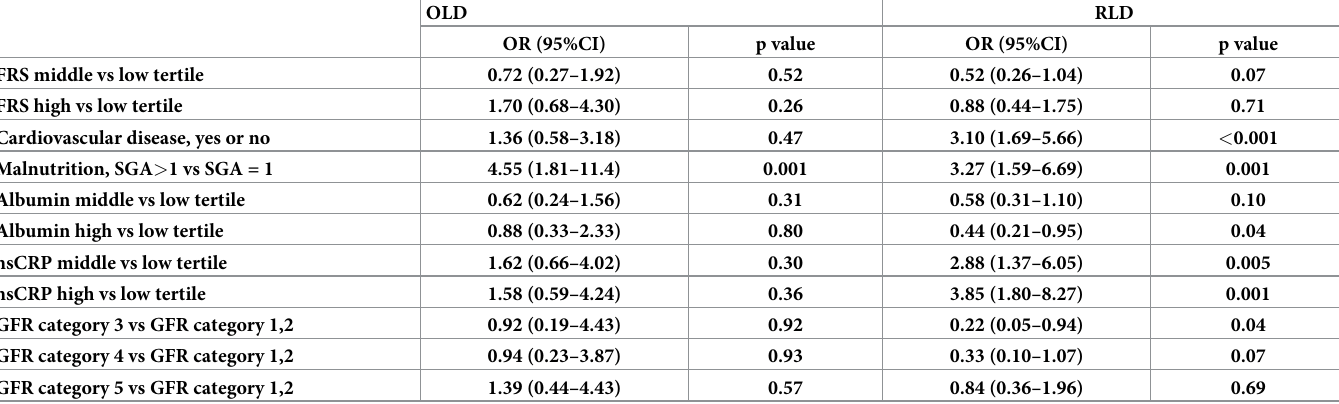
Table 2. Multivariate logistic regression analysis of factors associated with obstructive (OLD) and restrictive (RLD) lung dysfunction in 404 individuals with GFR categories